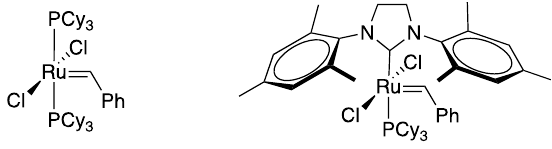
Figure 3. Grubbs’